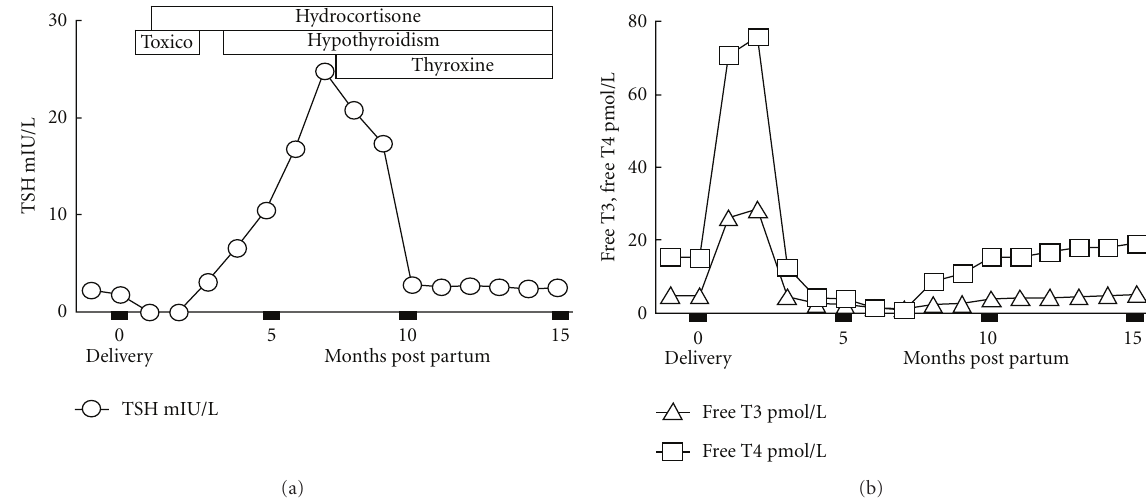
Figure 1: The clinical course of a patient with postpartum hypopituitarism (Sheehan’s syndrome: SS), who developed postpartum autoimmune thyroiditis (PPAT) (transient thyrotoxicosis and hypothyroidism). A 36-year-old woman delivered a full-term baby by